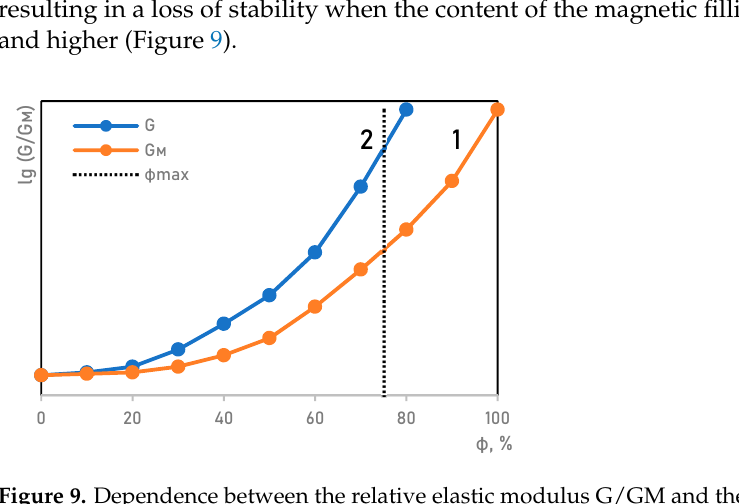
Figure 9. Dependence between the relative elastic modulus G/GM and the filling agent content φ : ( 1 ) design curve disregarding the limiting particle packing; ( 2 ) curve including the limiting (dense) particle packing φ max .